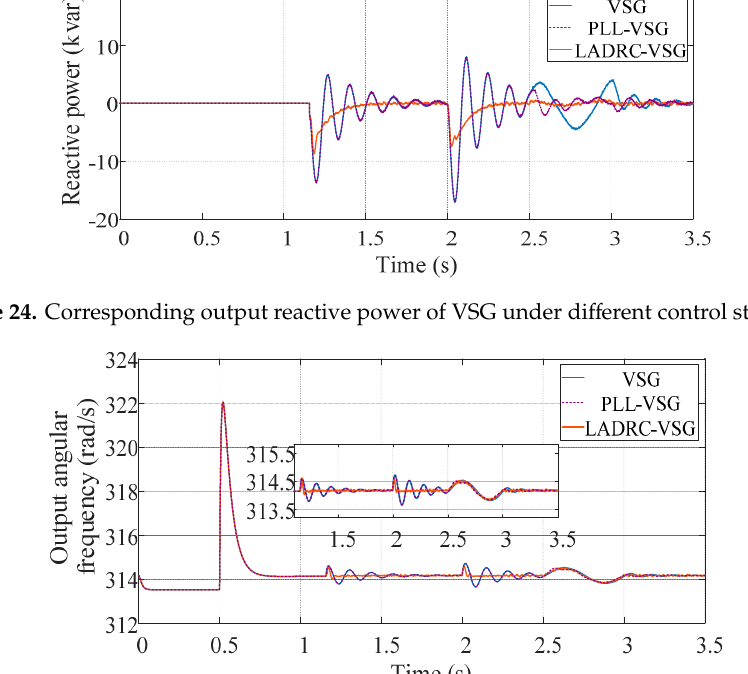
Figure 25. Output angular frequencies of inverter under different control strategies.